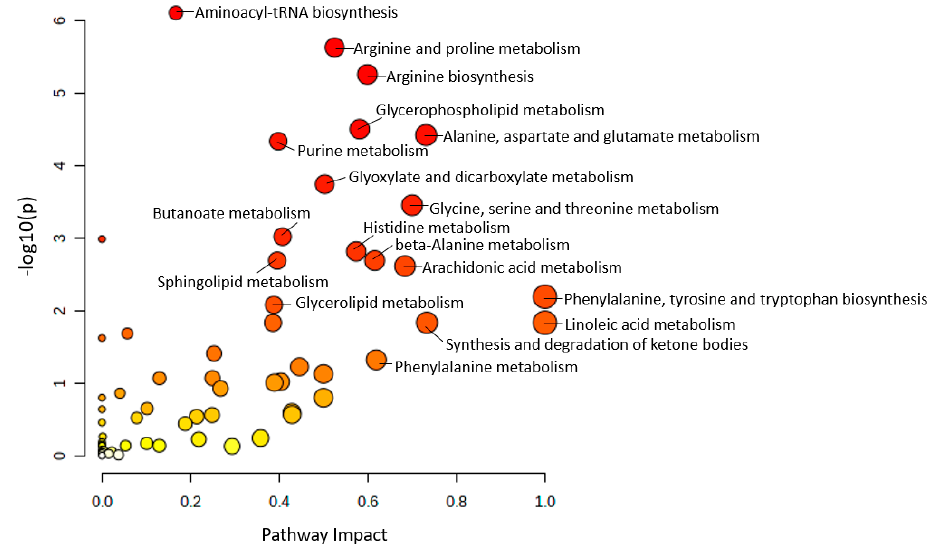
Figure 3. Metabolic pathway analysis in biological samples (brain and plasma) of 42 mouse studies. The size of the circle corresponds to the pathway impact score and was correlated with the centrality of the involved metabolites. Darker circle colors indicated more significant changes in metabolites in the corresponding pathway.